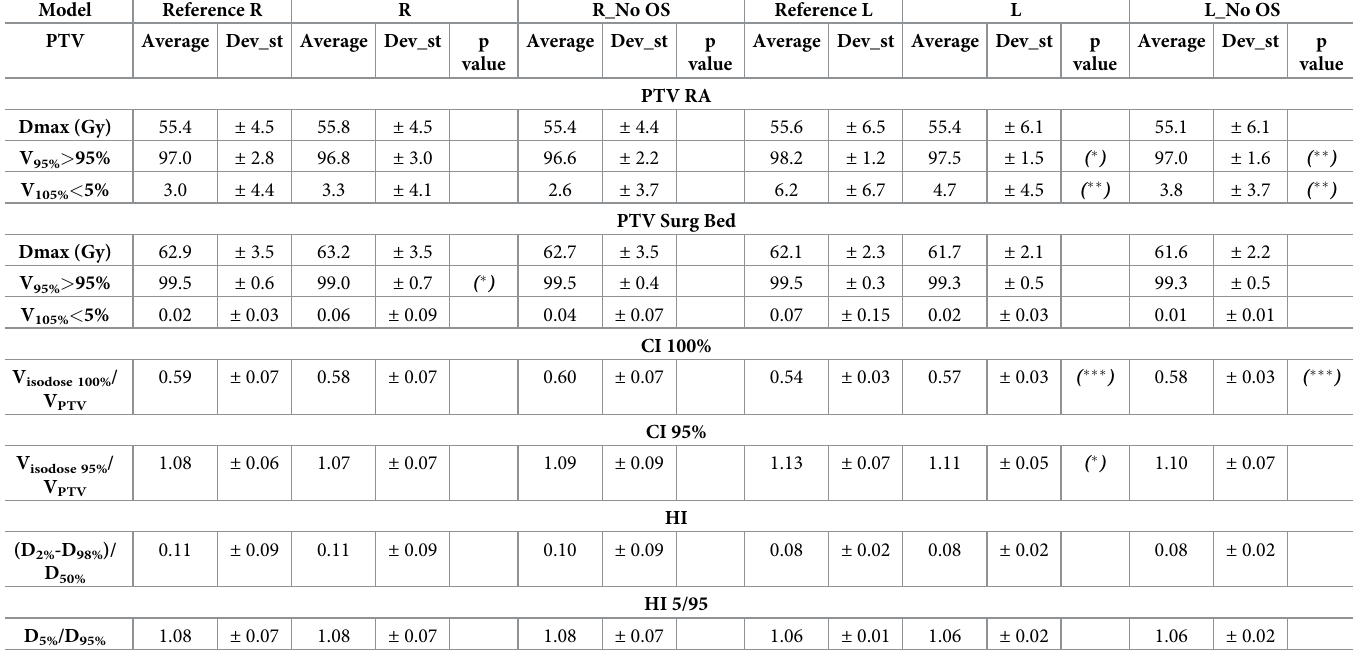
Table 4. Overview and comparison of relevant DVH parameters for PTVs, averaged for the 18 patients of validation set, treated on the right side and for the 12 patients treated on the left side, both for reference and model-based plans. Model Reference